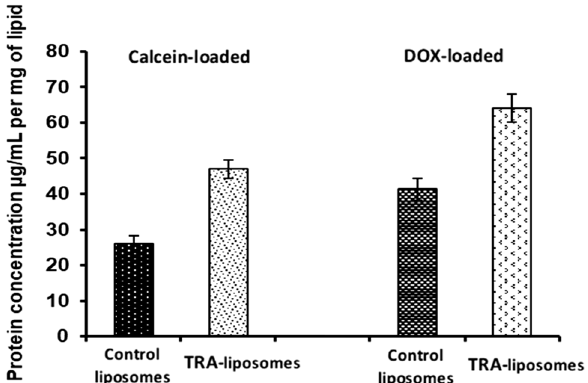
Figure 1. Protein concentrations (per mg of lipids) for the control and TRA-liposomes in both calcein and DOX-loaded